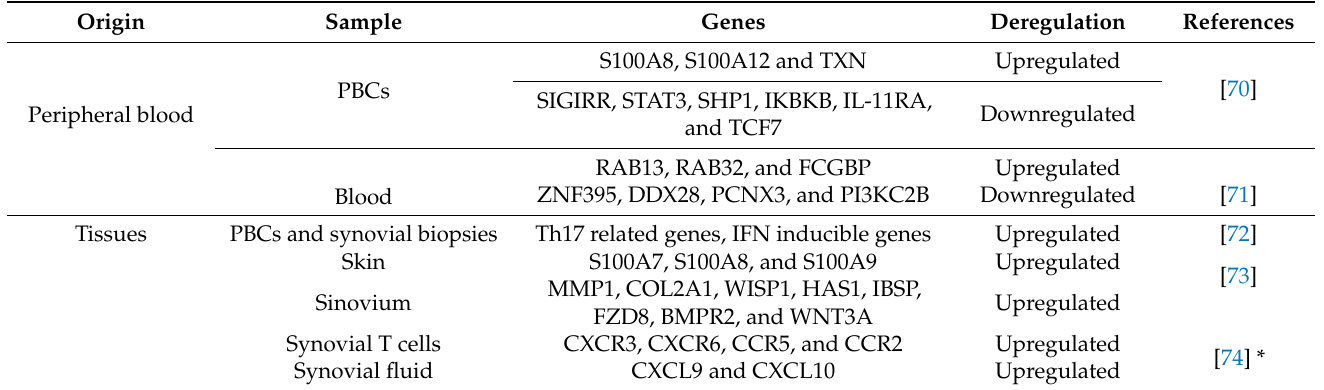
Table 3. Transcriptomic studies in psoriatic